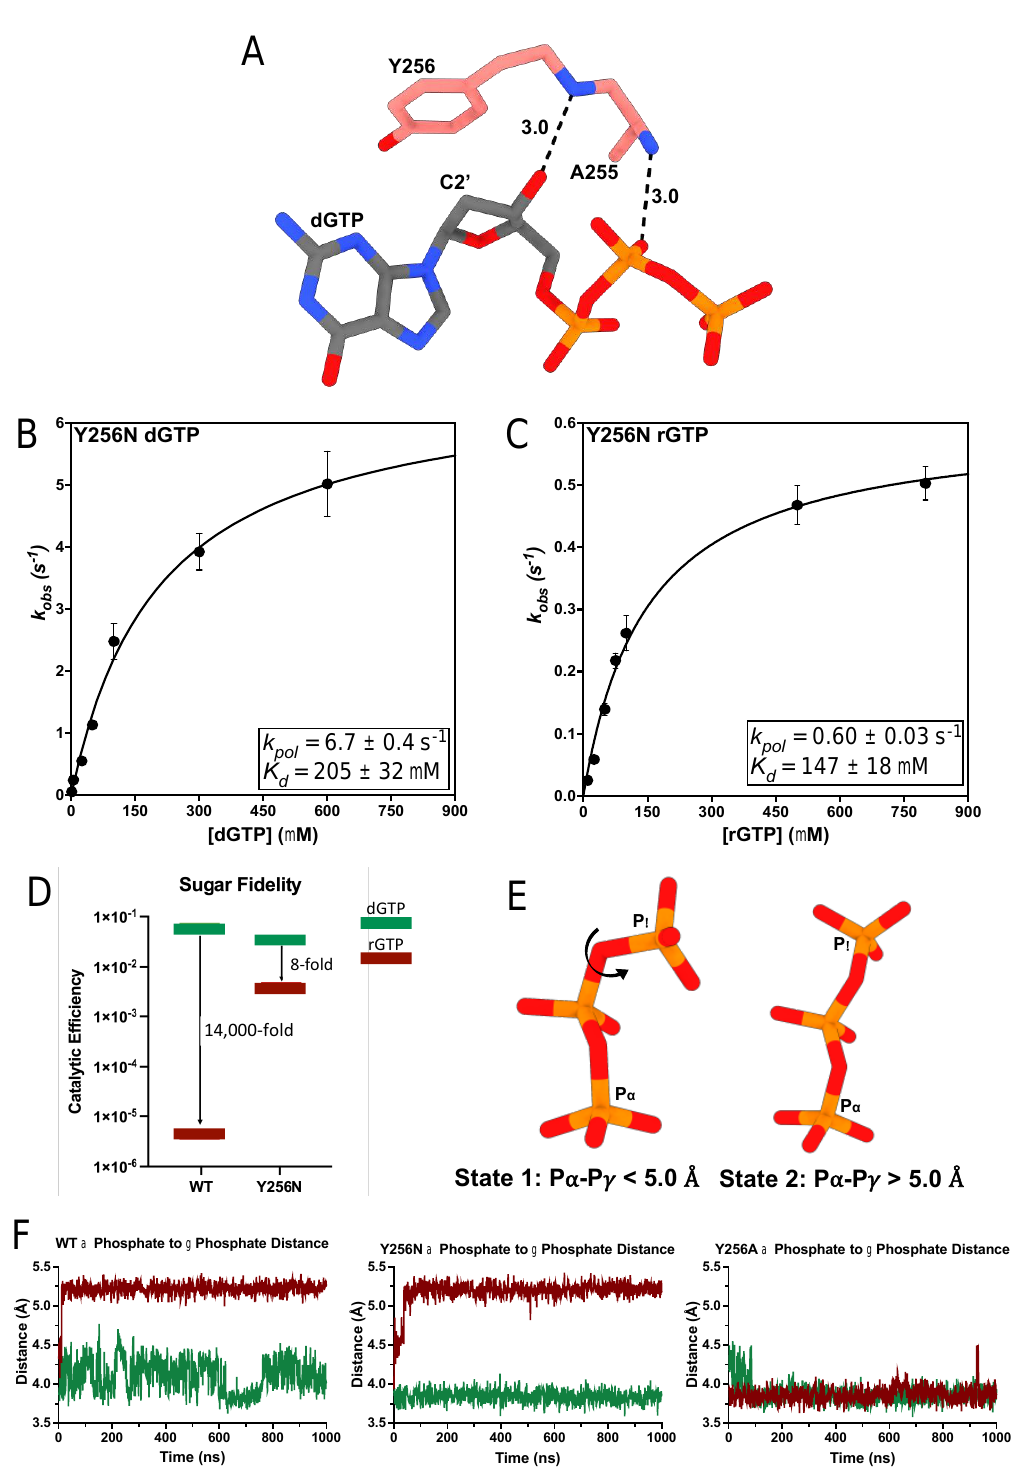
Figure 4. Mechanism of Y256N nucleotide insertion. ( A ) Interactions between A255 and Y256 with the incoming nucleotide (PDB: 7KQN). Hydrogen bond distances are represented with black dashes and measured in angstroms. ( B ) Replot of k obs values from single-turnover kinetics of Y256N inserting dGTP with the k pol and K d indicated. ( C ) Replot of k obs values from single-turnover kinetics of Y256N inserting rGTP with the k pol and K d indicated. ( D ) Sugar fidelity for WT and Y256N. WT values are taken from a previous publication [22]. ( E ) The two triphosphate states observed in the rGTP simulations. ( F ) Trajectories of the P ⍺ -P 𝛾 distance for dGTP (green) and rGTP (red). Table 2. Summary of Kinetic Parameters.